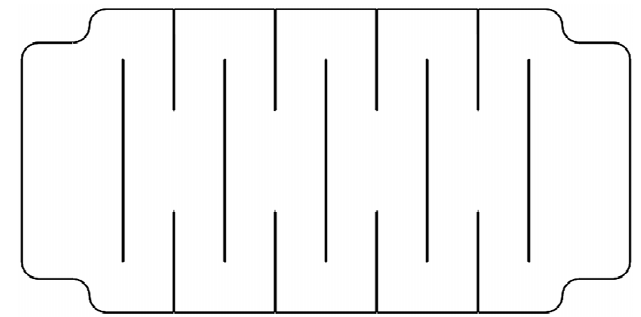
Figure A19. Spiral Fabric Design KS-6. Kirigami short cuts, Thermionyx fabric. References 1.